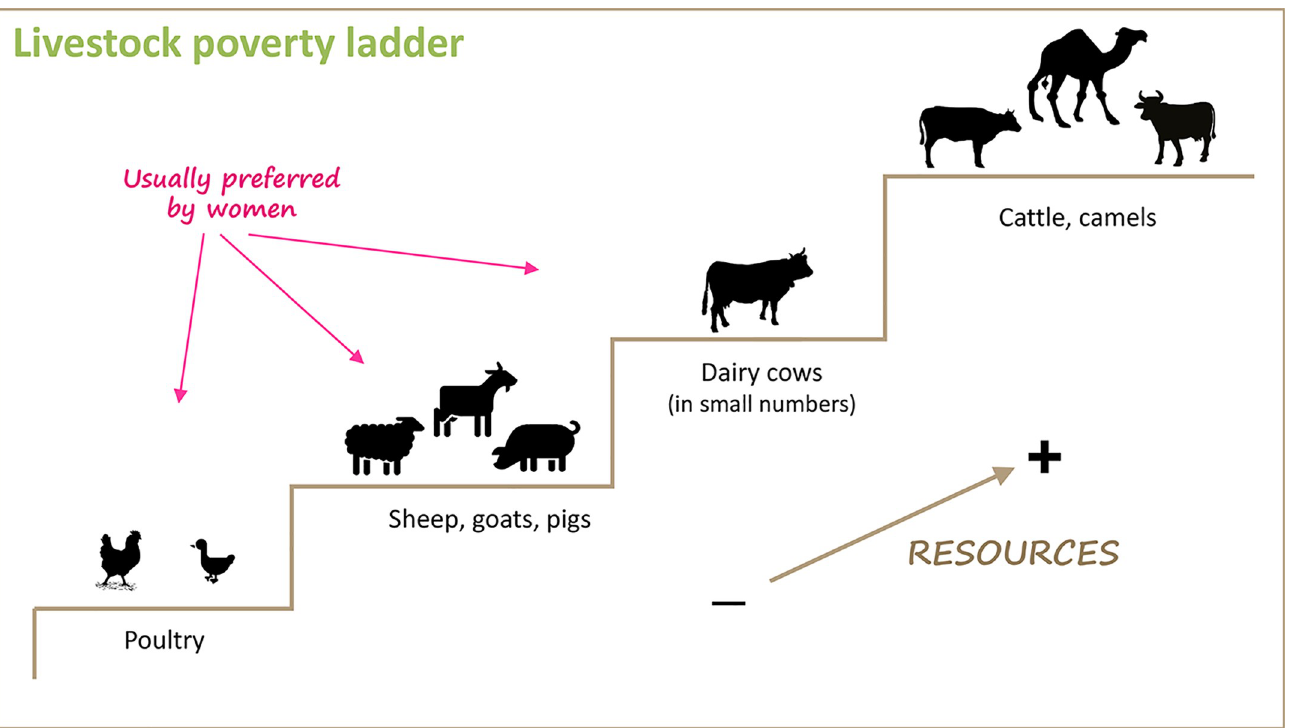
Fig 1. Livestock poverty ladder, species preference, and gender. Livestock species owned by the poor livestock keepers depend traditionally on their level of resources. Women usually prefer poultry, pigs, small ruminants and dairy cattle in small numbers, although there are exceptions. Some silhouettes obtained from: